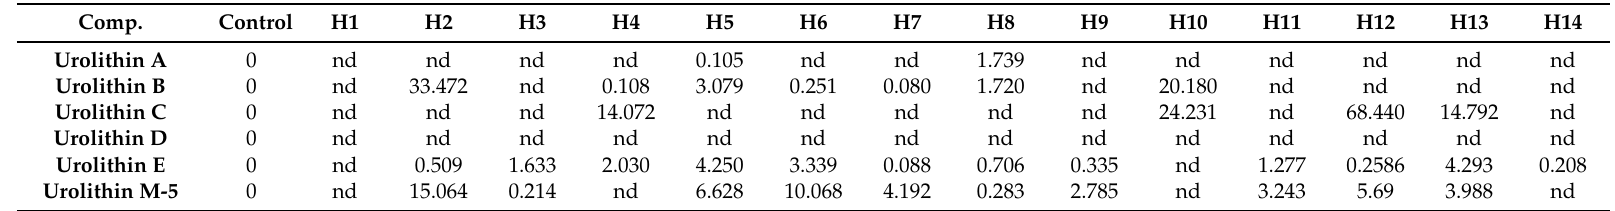
Table 2. Metabolism of ellagic acid ( µ M) by adult human gut